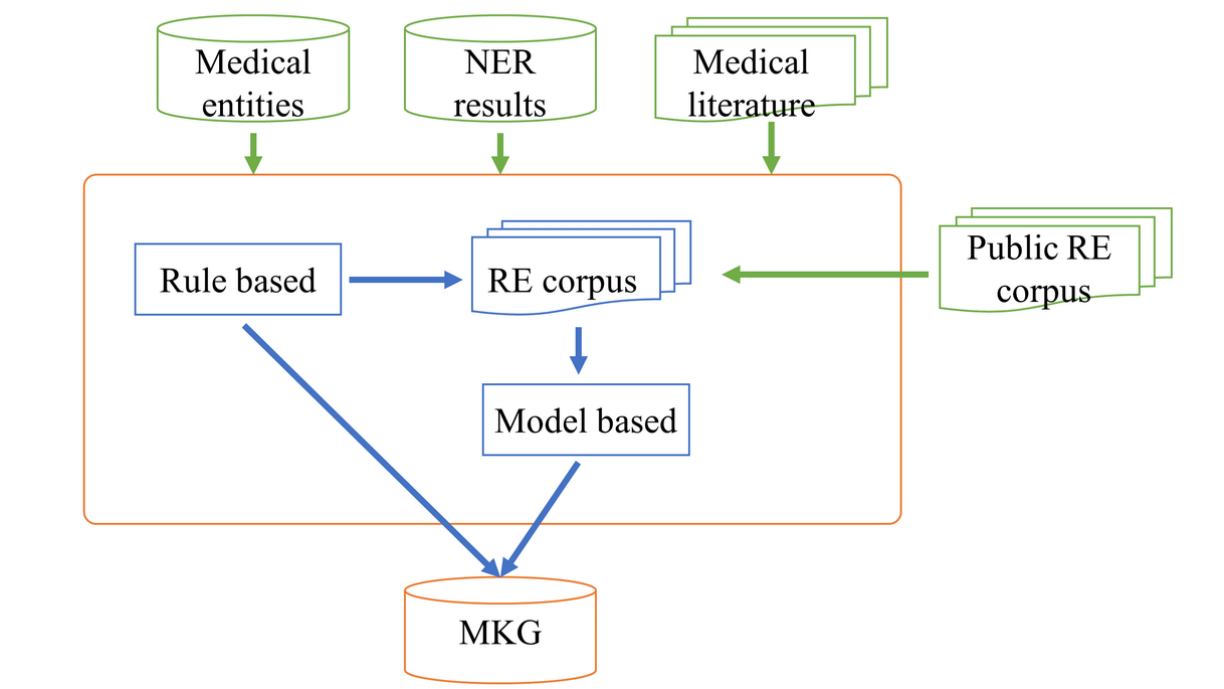
Figure 5. Framework of medical relation extraction (RE). MKG: medical knowledge graph; NER: named entity recognition.